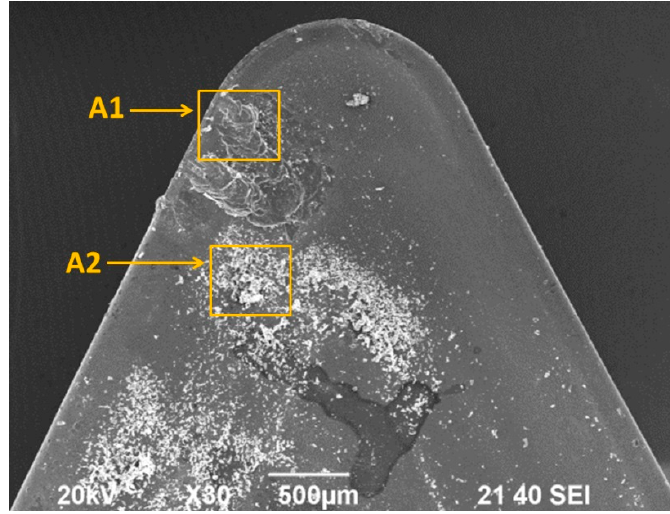
Figure 8. SEM image from the rake face ( v c = 170 m/min, f = 0.20 mm/r and a p = 1 mm).